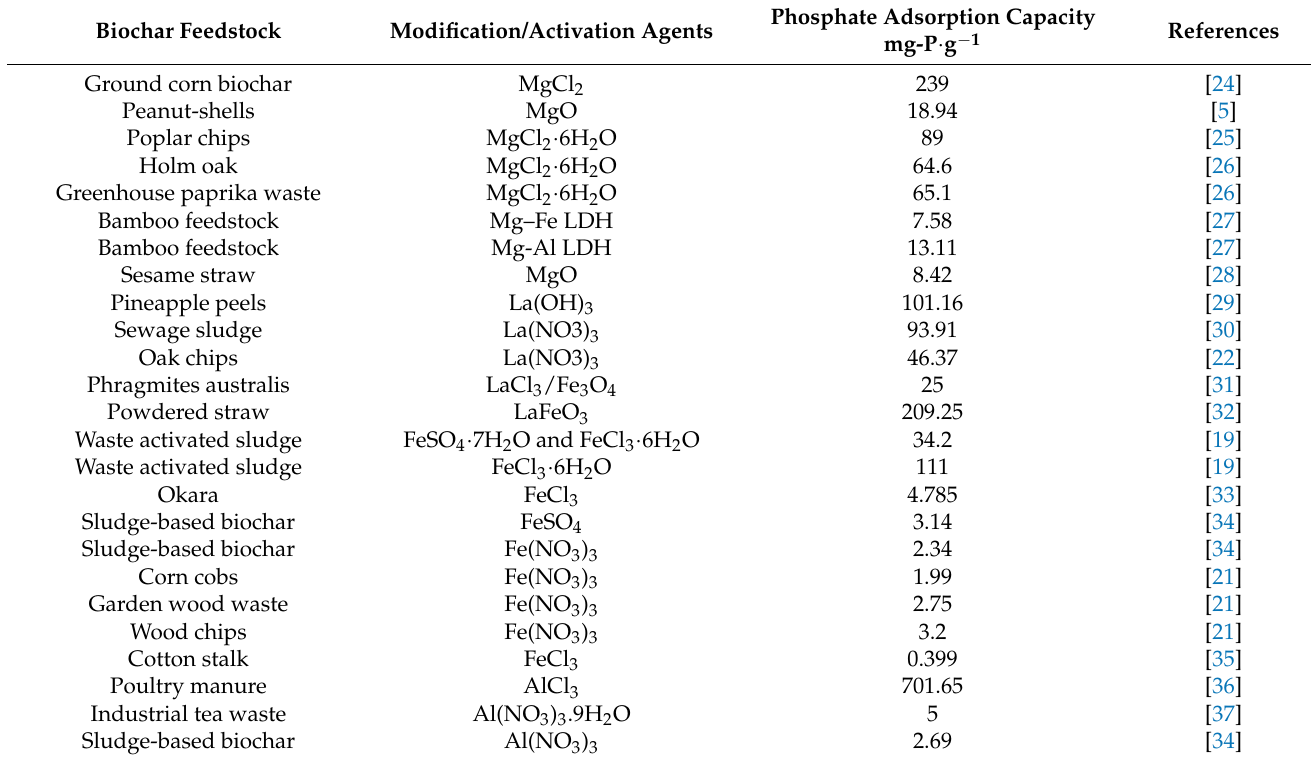
Table 2. P adsorption capacity of biochar using different modification